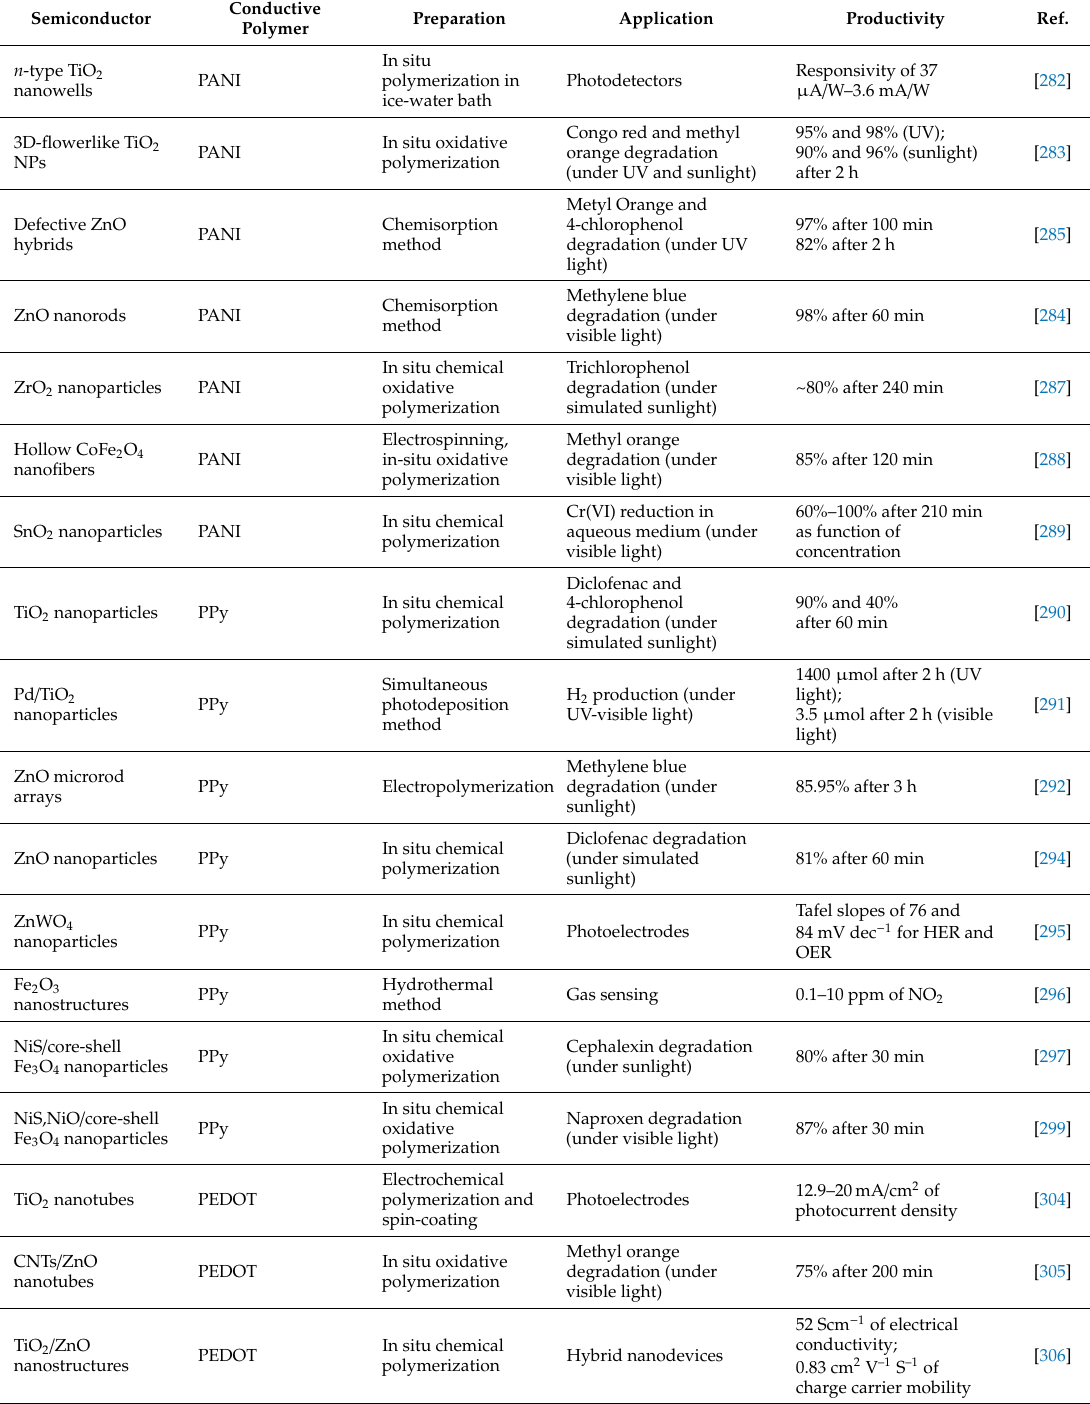
Table 6. Main properties of semiconducting polymer / metal oxides hybrid nanomaterials and their photocatalytic activity data under visible irradiation or solar light irradiation. The best results achieved in each work are